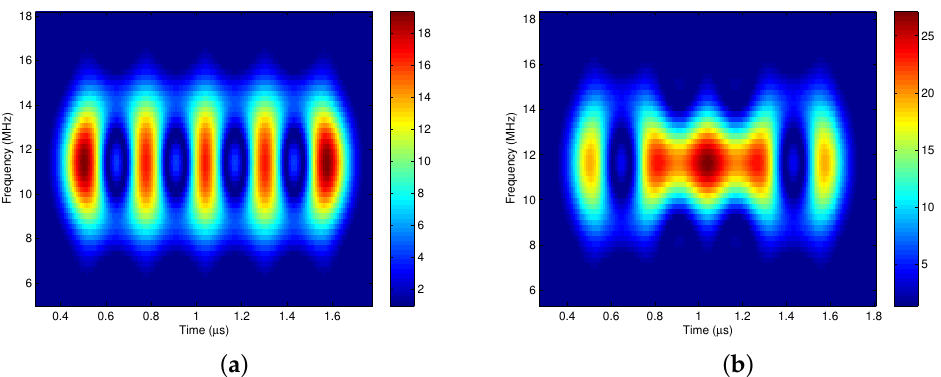
Figure 4. The time frequency distribution for pulse shaping signals. ( a ) Data stream { 1, − 1,1, − 1,1 } ; ( b ) data stream { 1, − 1, − 1, − 1,1 }